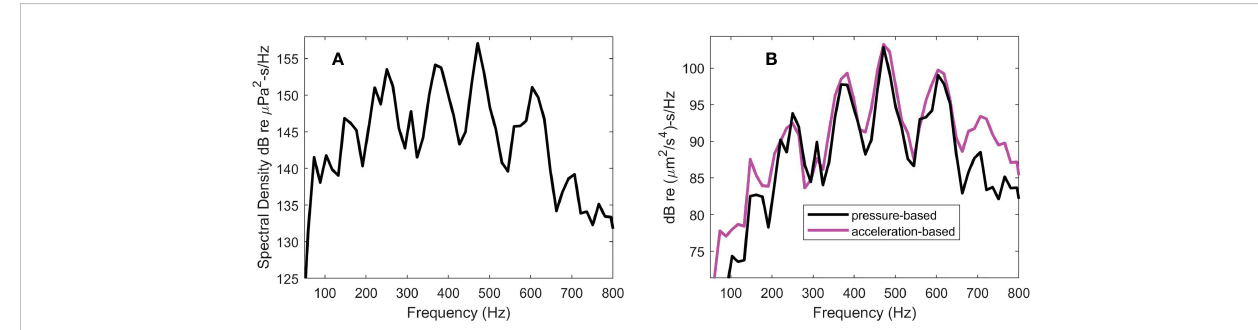
FIGURE 7 Spectral densities for pile T8, range 10 m (A) Sound exposure level (SEL) spectral density S p ( f ) (B) Acceleration exposure spectral density as derived with pressure data A p ( f ) (black line) and velocity data A k ( f ) (magenta